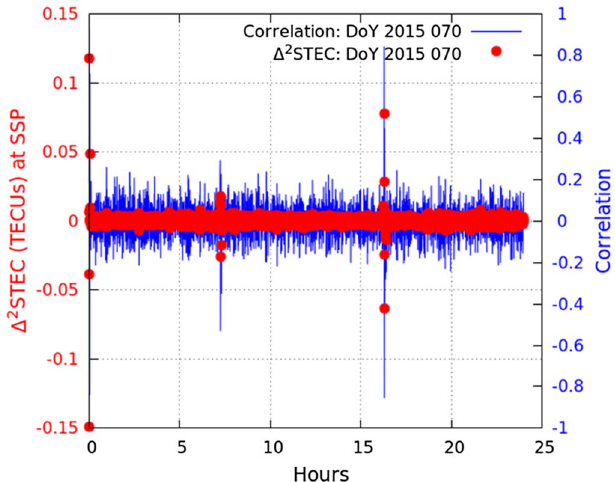
Fig. 7. D 2 STEC at the SSP (red points) and the corresponding correlation coef fi cient of the fi ttings (blue line) for March 11,